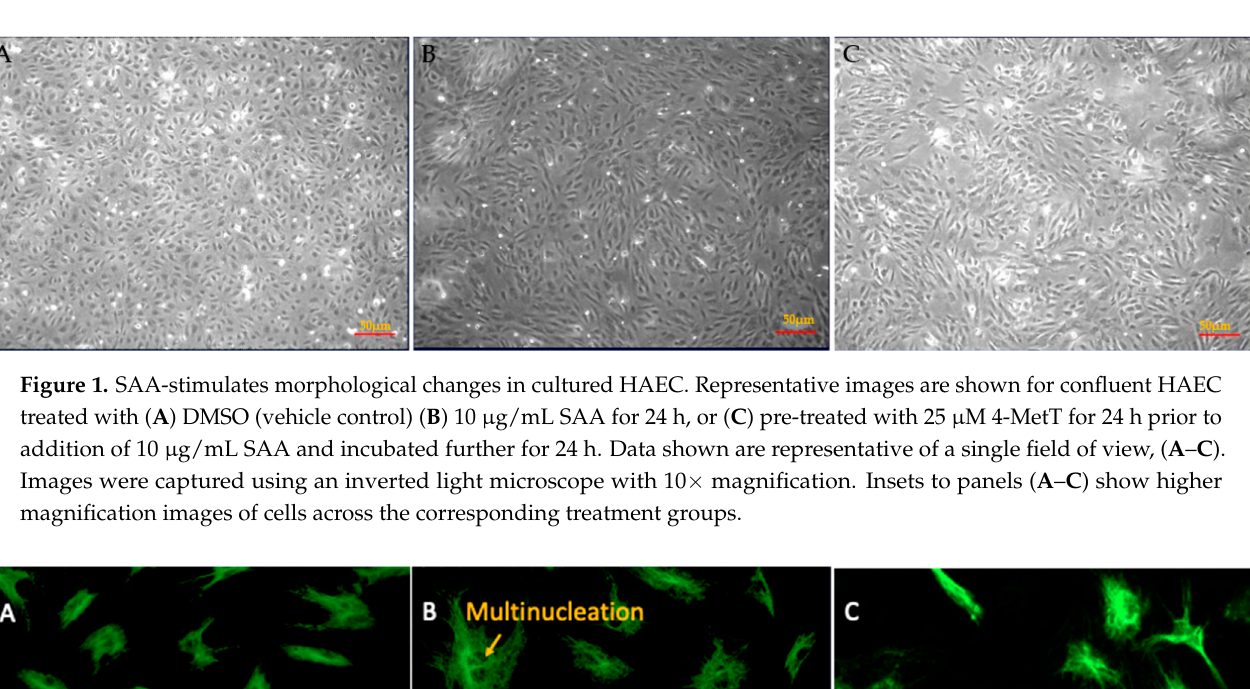
Figure 2. Changes in the cytoskeletal protein, alpha-tubulin in response to incubation of HAEC with SAA, with and with- out added 4-MetT. Representative images correspond to ( A ) Control ( B ) 10 µg/mL SAA ( C )10 µg/mL SAA + 25 µM 4-MetT pre-incubation. Data shown are representative of ( n = 3 control, n = 5 SAA, SAA + 4-MetT) independent studies.